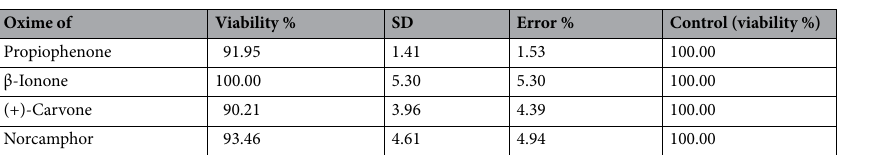
Table 2. The percentage of viable HEK293T cells after 24 h of incubation with 25 µM of the indicated oxime. SD standard